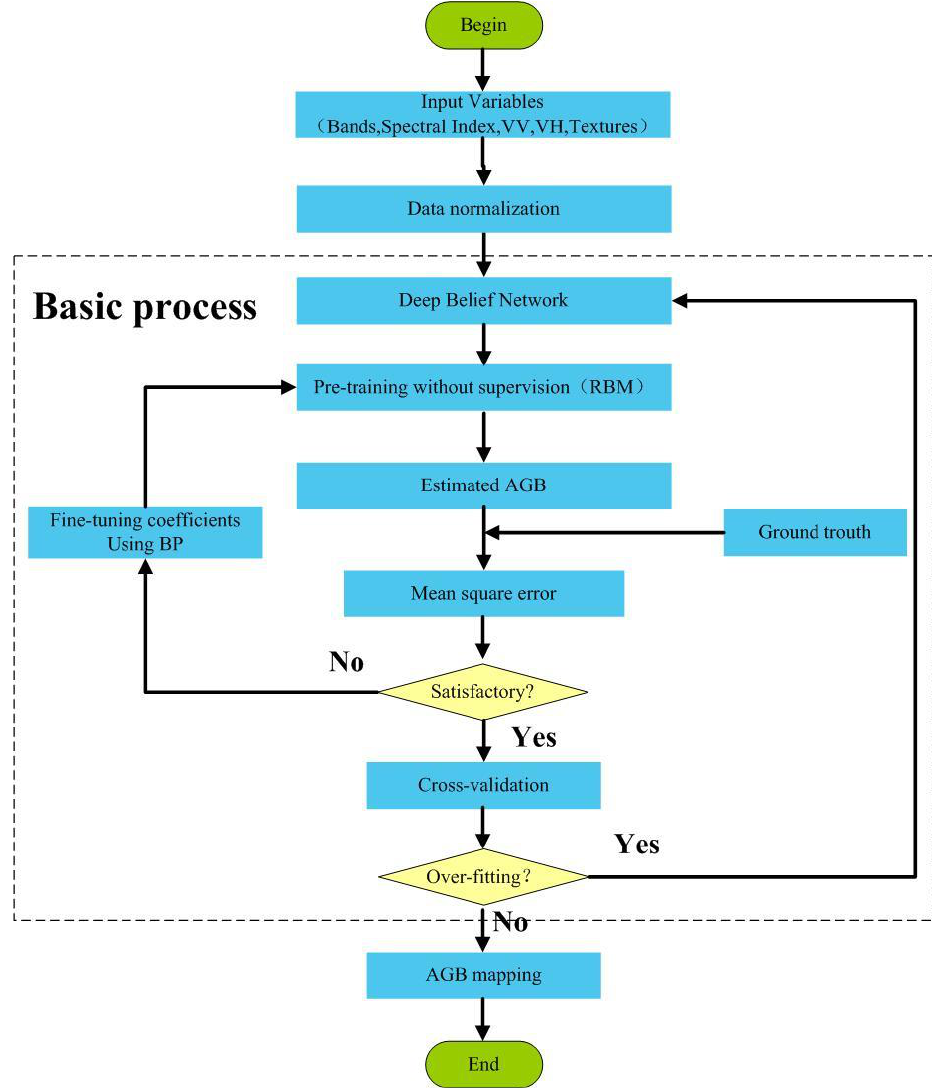
Figure 5. Flow chart of the AGB estimation algorithm based on DBN.